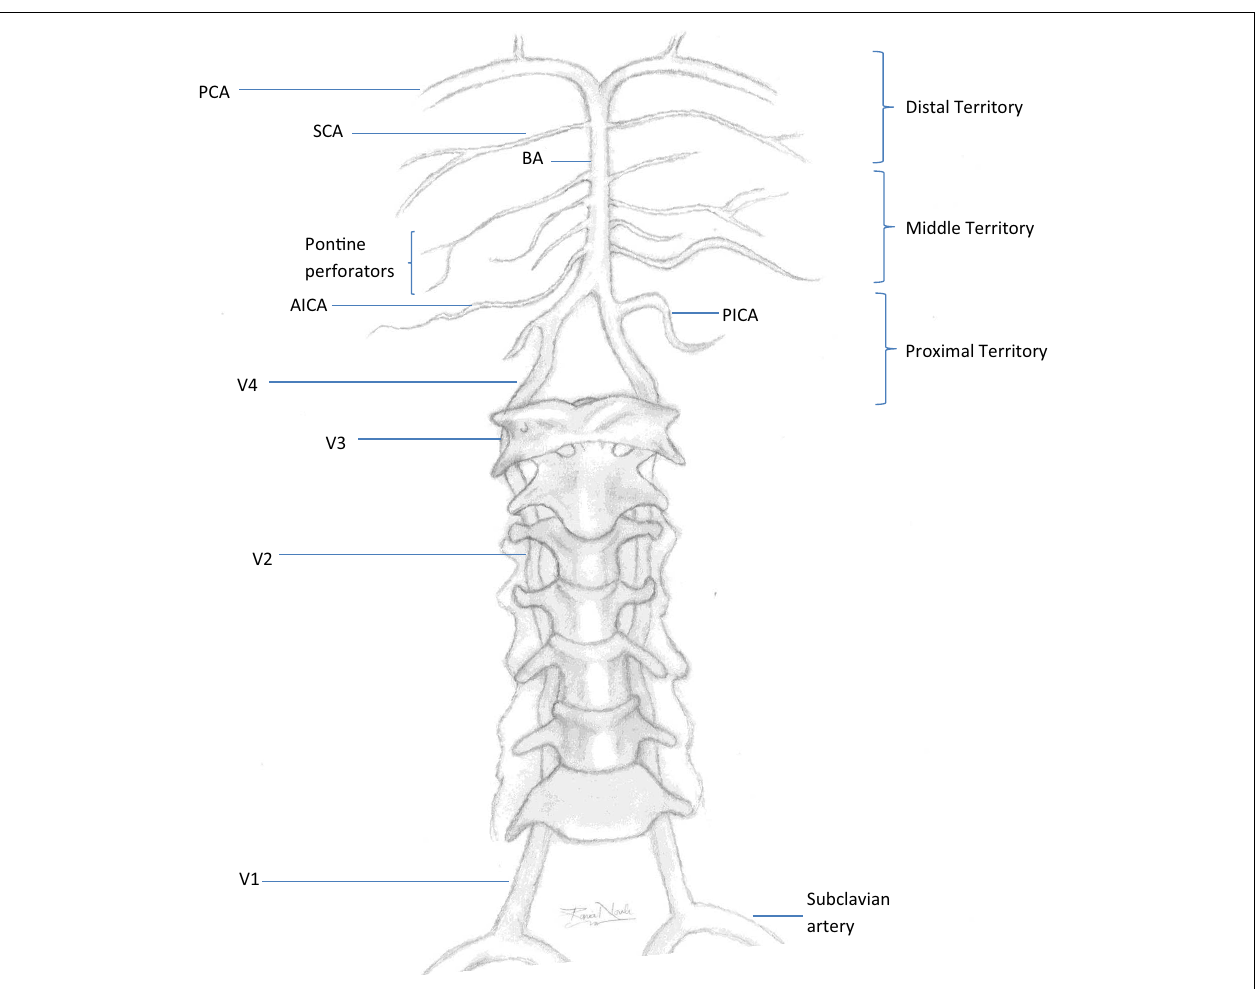
vertebral artery. Proximal territory, areas supplied by the intracranialVAs and PICAs up to theVB junction; middle territory, BA and AICAs up to the SCAs; distal territory, rostral BA, SCAs, and